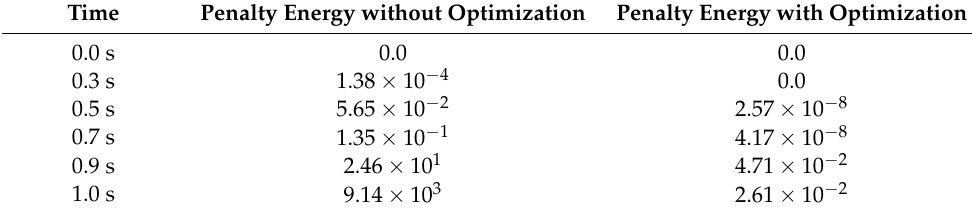
Table 4. Value of penalty